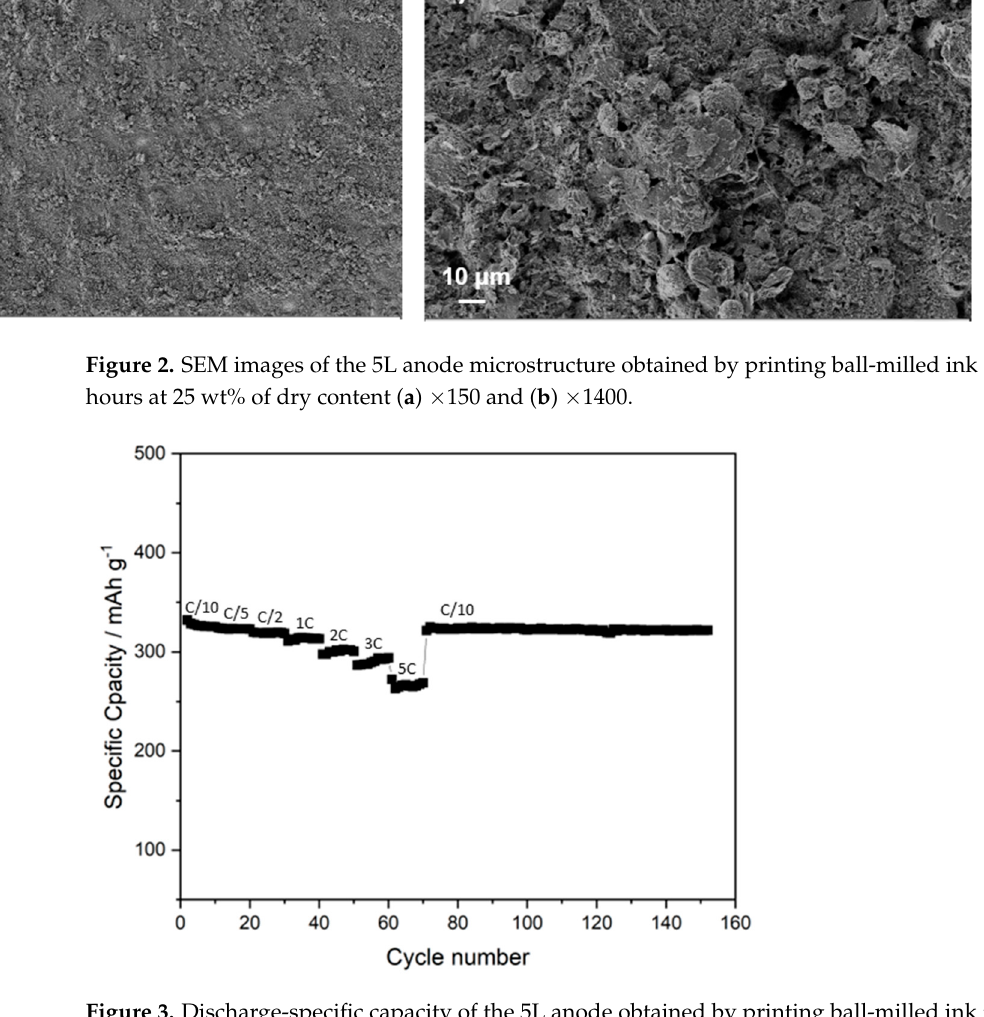
Table 1. Characteristics of the gravure-printed anodes.